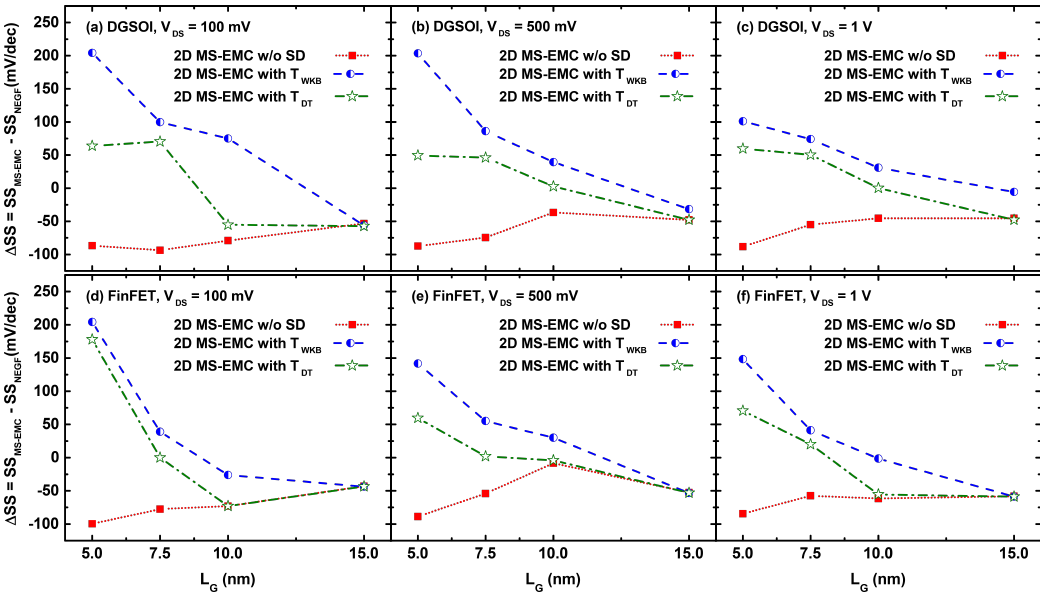
Figure 6. ∆ SS as a function of the gate length in the DGSOI and FinFET devices at V DS = 100 mV ( a , d ), V DS = 500 mV ( b , e ), and V DS = 1 V ( c , f ), calculated as the difference between the 2D NEGF-NESS